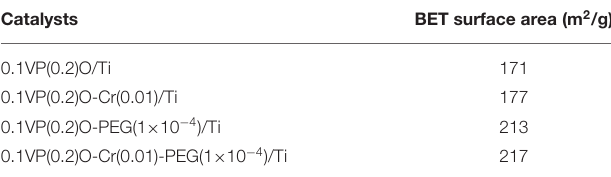
insufficient, which lead to the decrease of denitration efficiency. TABLE 1 | BET surface area of